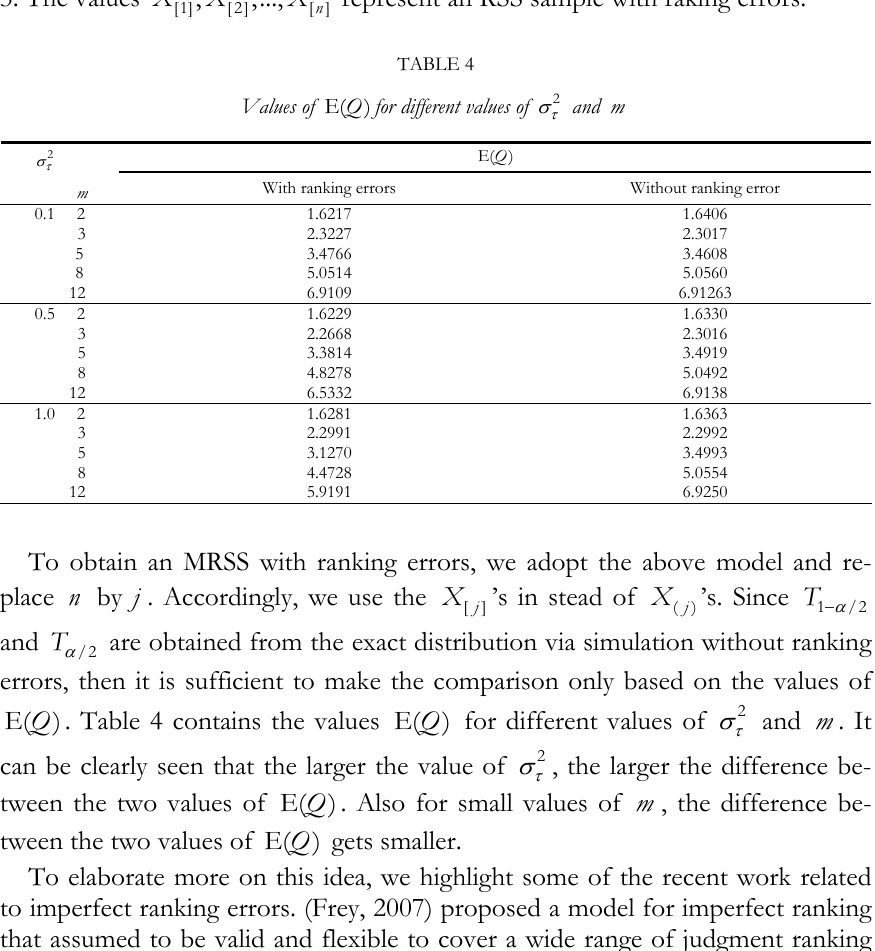
represent an RSS sample with raking errors.